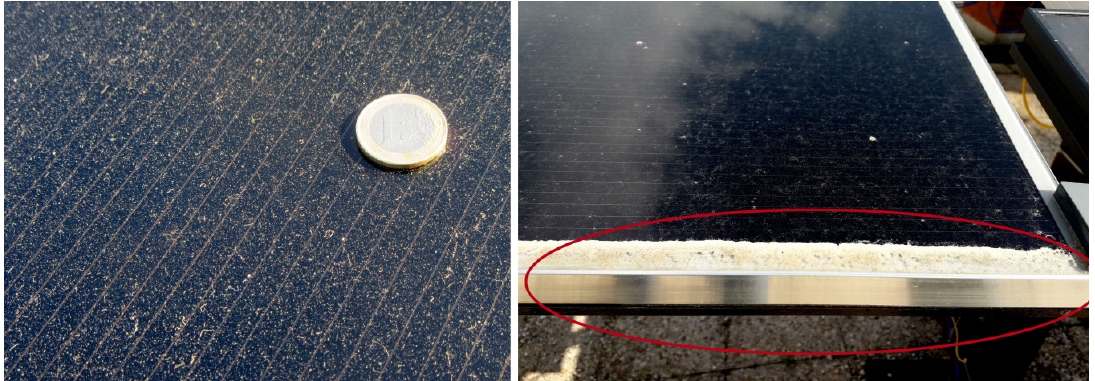
Figure 7. CdTe modules soiled by pollen: ( a ) uniform soiling and ( b ) non-uniform soiling.